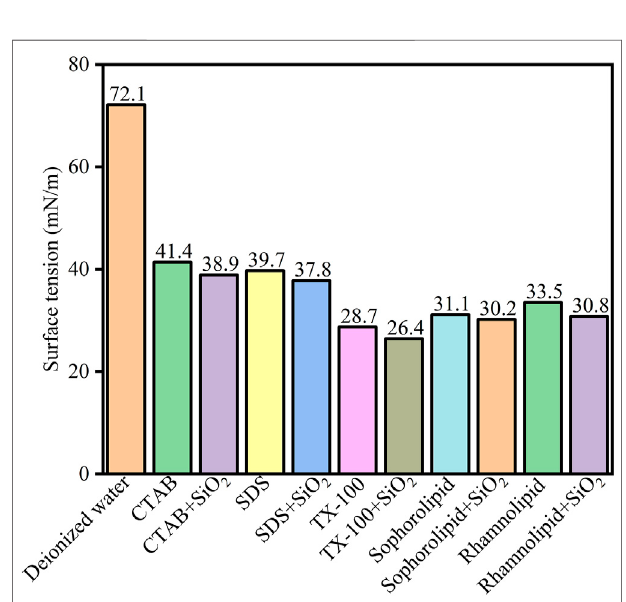
FIGURE13| Surfacetension(mN/m)ofthedeionizedwater,surfactants solutions (2000 ppm) and surfactant (2000 ppm)-SiO 2 nanoparticles at 298